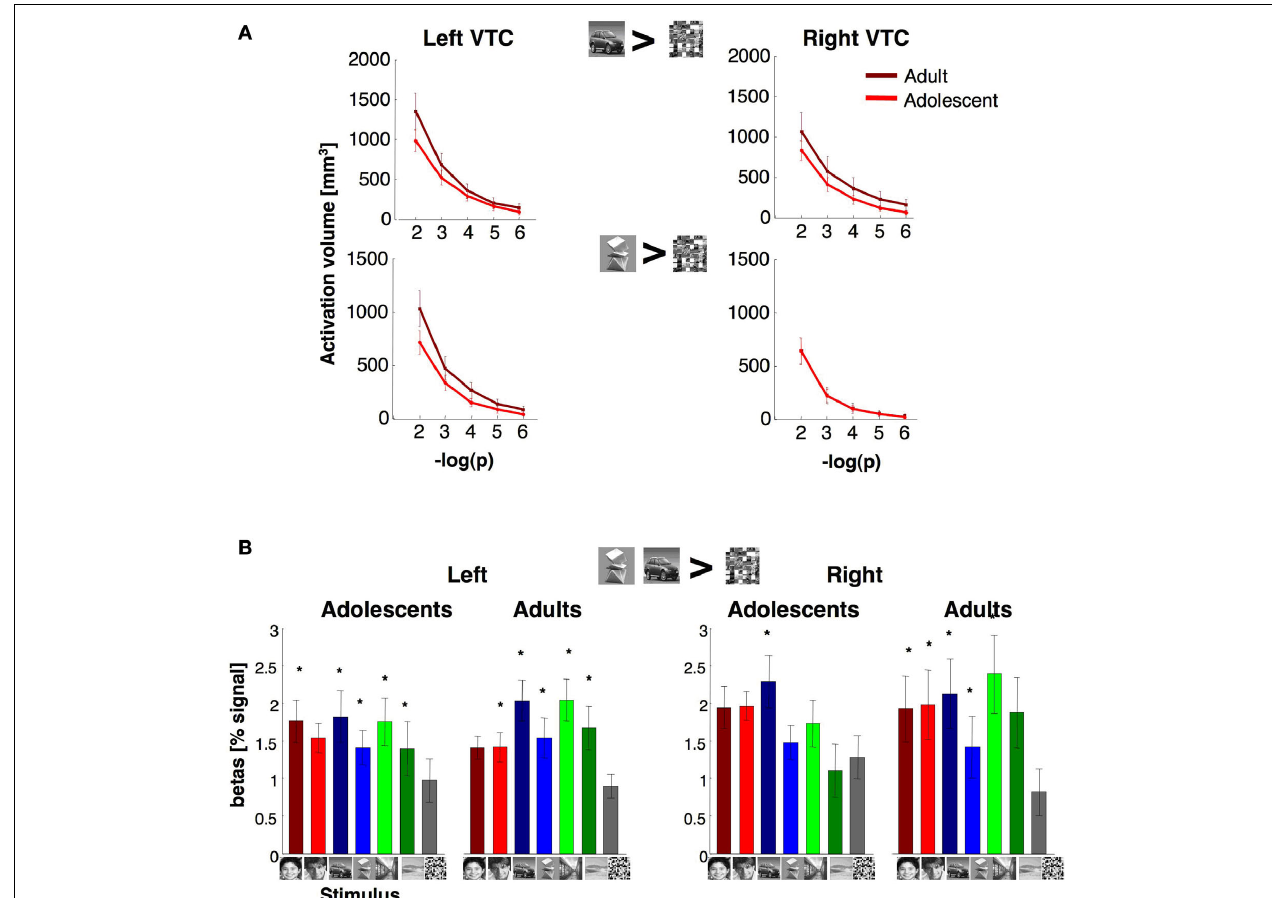
FIGURE 8 | Volume and response amplitudes of object selective activations in VTC. (A) The total volume of activated voxels for cars > scrambled, or abstract objects > scrambled at fi ve different thresholds (10 –2 to 10 –6 , shown as minus logarithm base 10, uncorrected). Light red : adolescents (ages 12–16 years, n = 14); dark red : adults (ages 18–40 years, n = 11). (B) Percent signal change for object selective voxels. We defi ned in each subject object selective voxels in the VTC using the contrast: cars and abstract objects > scrambled, P < 10 –3 ,